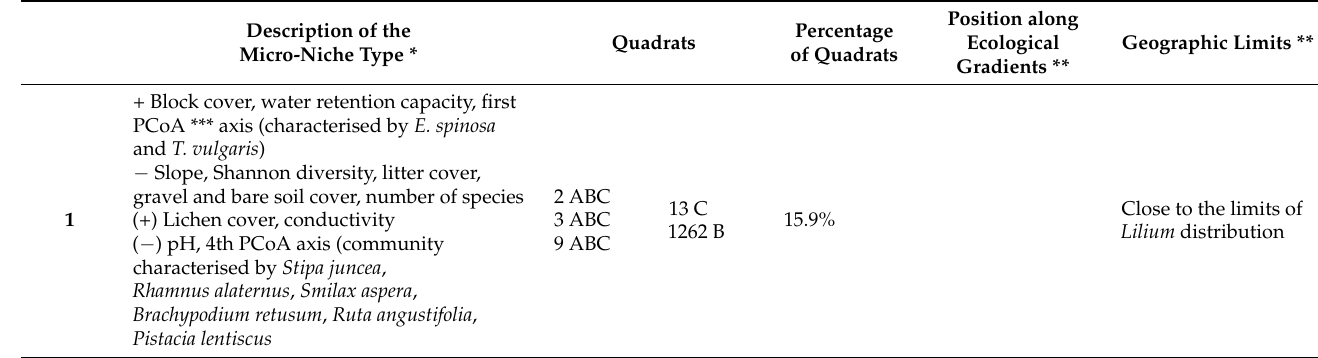
Table 1. Description of the four micro-niche types in relation to parameters analysed by HCPC on MFA, and their position along ecological (climatic) gradients and in relation to geographic distribution limits. Symbols indicate whether the mean value of the niche type is significantly higher+ or lower– than the overall mean. A sign in parenthesis indicates significantly higher standard deviation within a given micro-niche type. Quadrat number is the code for the study site and A, B, and C represent the three quadrats in a given site.